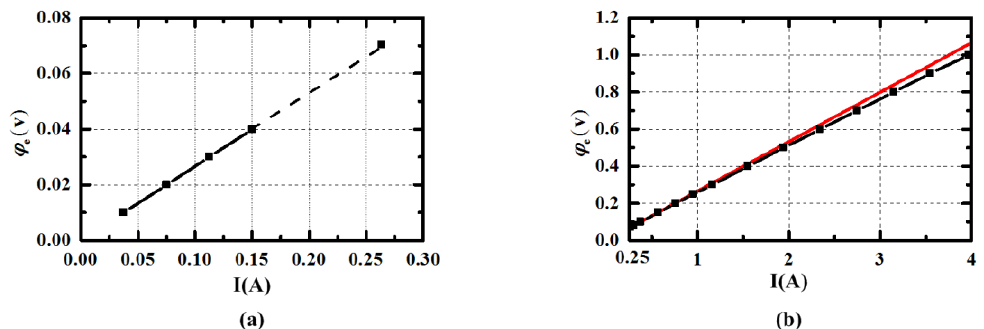
Figure 12. The voltage φ m between the energized electrodes when applied different current I . (The dotted portion means that the stable display cannot be acquired).